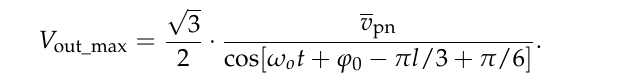
Figure 1. Its input signal is the difference between q-axis voltage references before and after over-modulation. Its output signal is used to adjust the d-axis current of